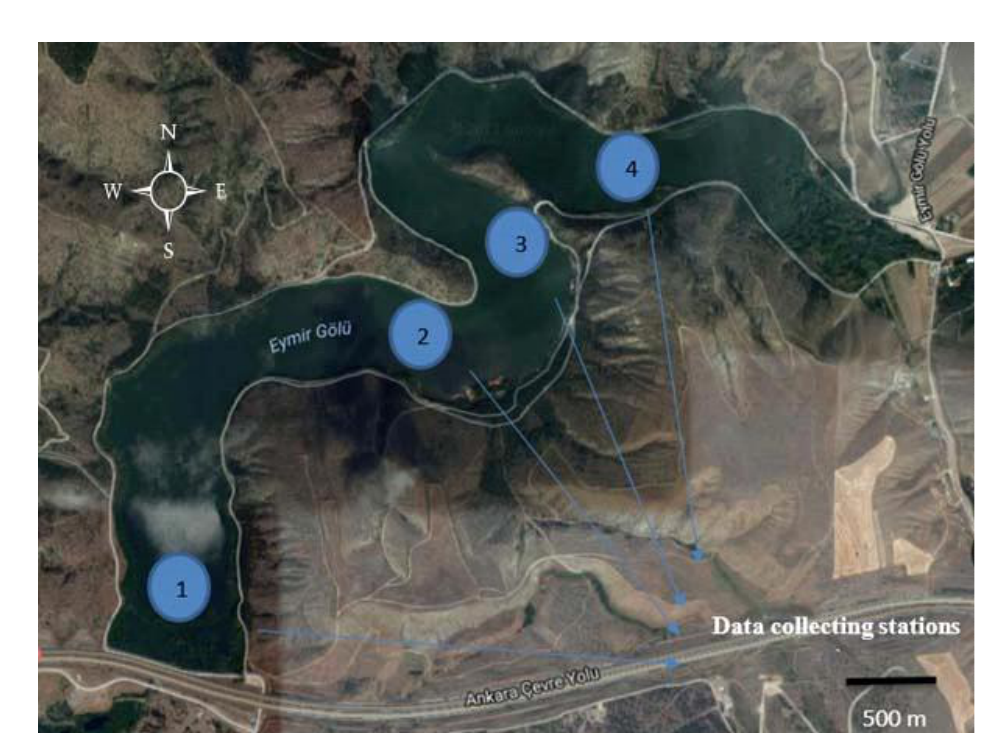
Fig. 2: Four data collection points among the lake